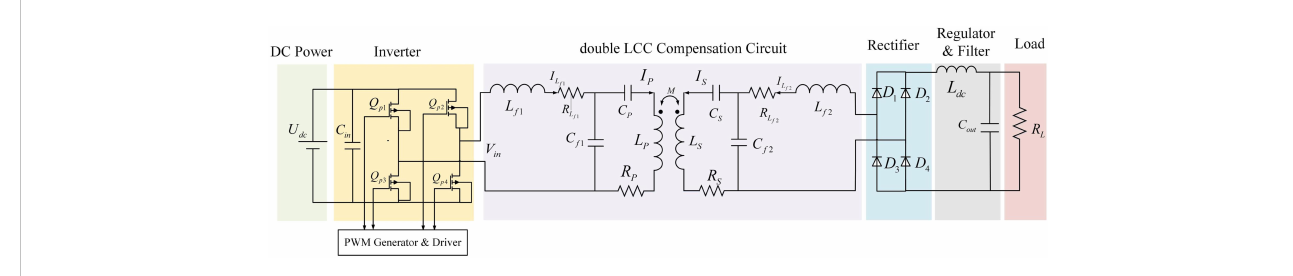
FIGURE 6 The schematic diagram of the OPCT-NWMC